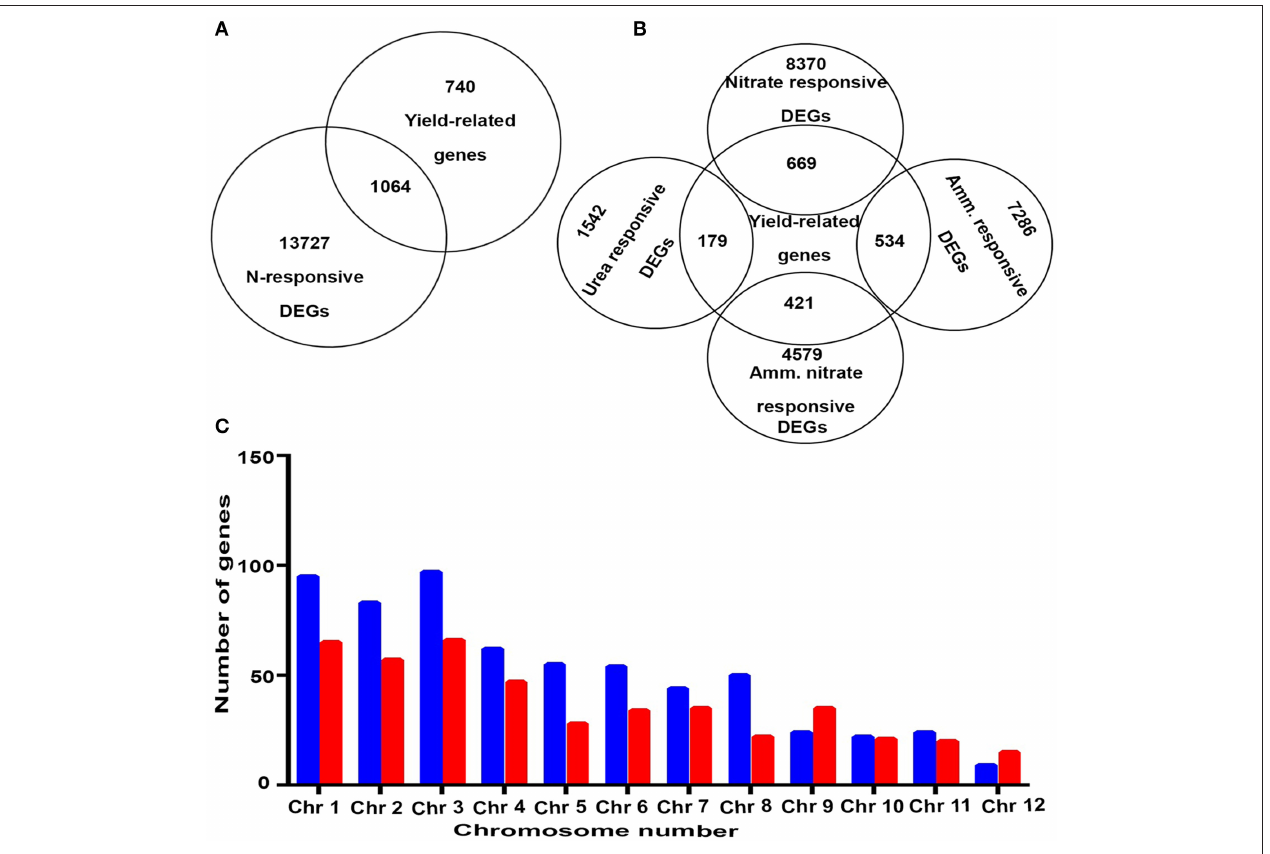
FIGURE 2 | (A) A Venn diagram showing exclusively yield-related genes, N-responsive and yield-related genes, and exclusively N-responsive genes. (B) A Venn diagram showing common genes between yield and those that respond to specific N-forms. (C) A bar graph depicting chromosomal localization and upregulated and downregulated NUE-related genes. Blue color represents upregulated genes and red color represents downregulated